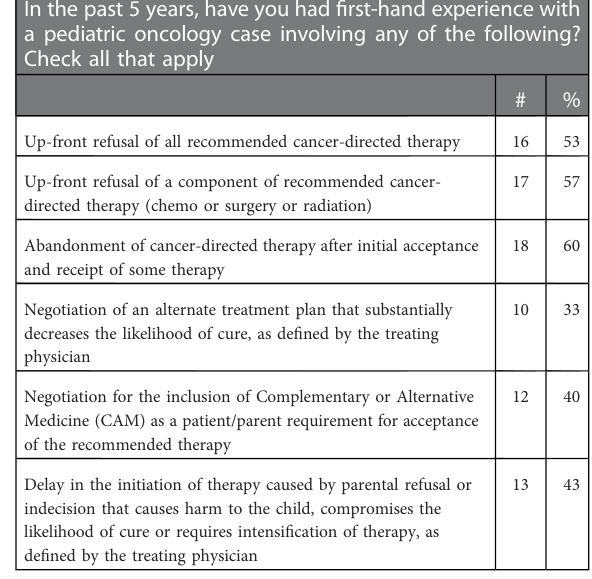
TABLE 1 Interviewee experiences with case